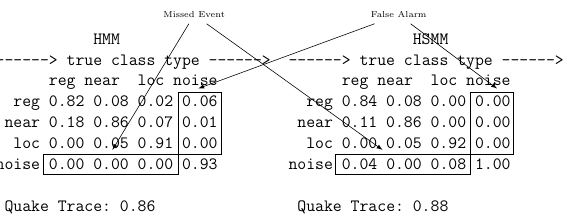
Fig. 8. Reevaluation of the training data. To the right the true class type is plotted; to the bottom the recognized one. E.g., for the HMM reg class, 82% of the data are correctly classified as reg and 18% are confused as near.